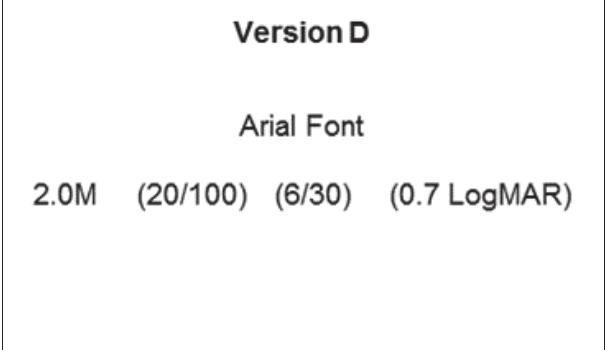
FIGURE 1: Version D of the paediatric rate of reading chart in Arial